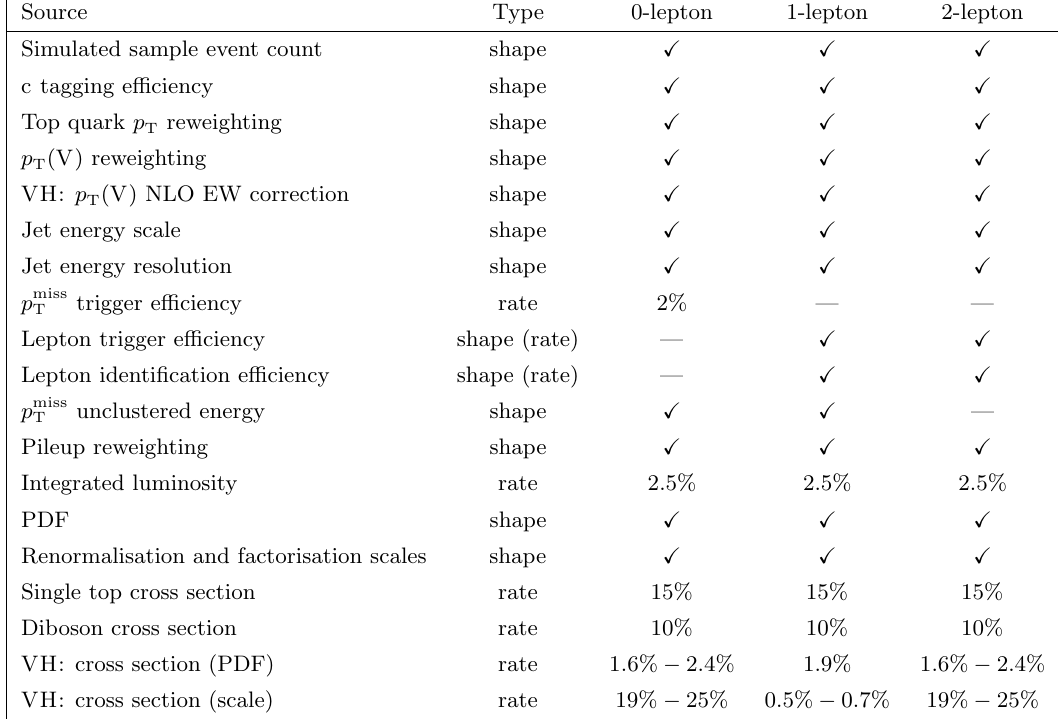
Table 3 . Summary of the systematic uncertainties for each channel. The shape uncertainties refer to systematic uncertainties that a(cid:11)ect both the shape of the distribution being (cid:12)tted as well as their normalisation. Uncertainties in the lepton identi(cid:12)cation and trigger e(cid:14)ciencies are treated as a normalisation uncertainty in the resolved-jet topology analysis and as a shape uncertainty in the merged-jet topology